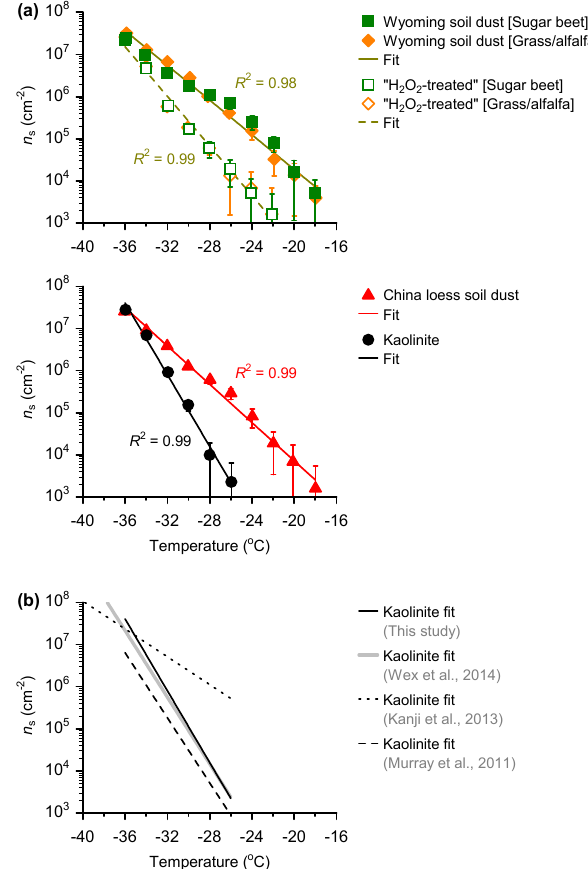
Figure A1. Fit to ice-nucleation active site densities for var- ious dusts. (a) Parameterizations of n s for untreated